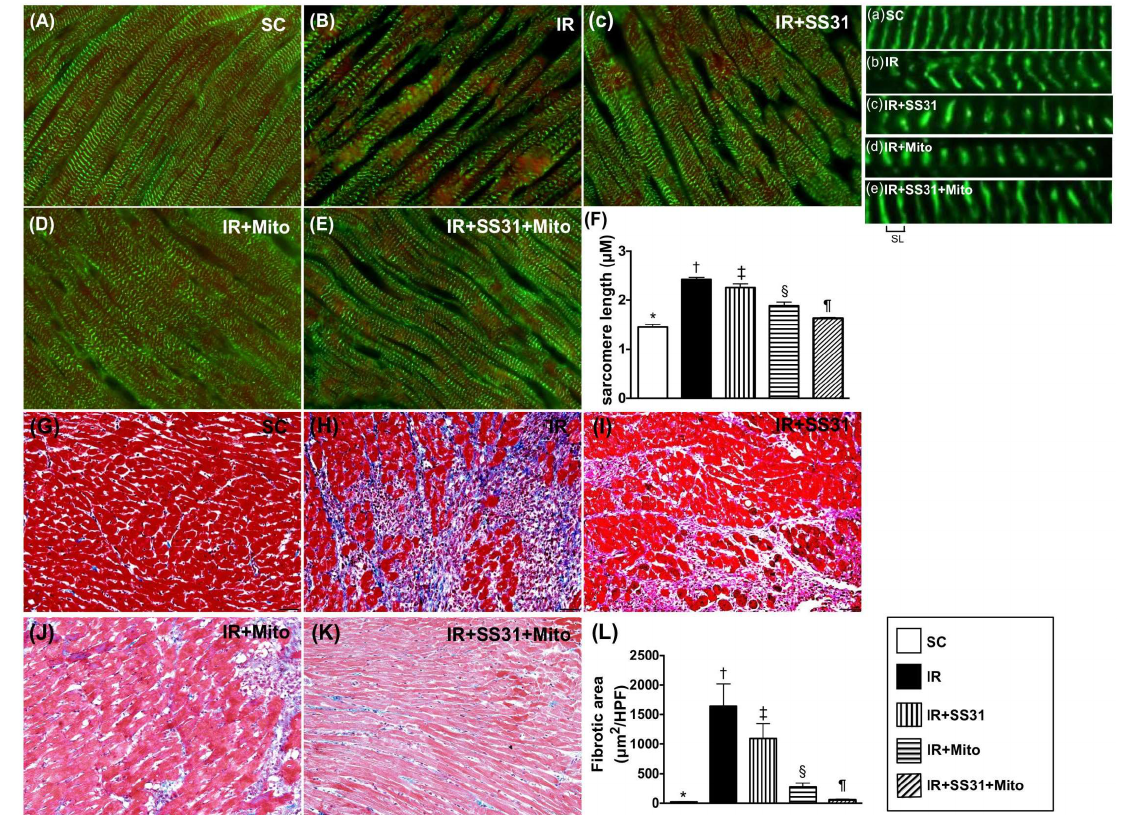
Figure 12. Actin-phalloidin staining ( A – E ) for measuring the sarcomere length of cardiomyocytes in LV myocardium after the IR procedure. ( A – E ) Immuno-fluorescent microscopic (1000 × ) finding for identifying the sarcomere length. ( a – e ) Illustrating the manifestations of distance of sarcomere length (SL) in five groups (i.e., ( A – E )). ( F ) Results of statistical analysis of the changes in length of sarcomere identified by troponin-I staining * vs. other groups with different symbols (†, ‡, §, ¶), p < 0.0001. The scale bars in the right lower corner represent 10 µ m. ( G – K ) Illustrating the Masson’s trichrome stain (200 × ) for identification of the fibrotic area (blue color). ( L ) Results of statistical analysis of the fibrotic area * vs. other groups with different symbols (†, ‡, §, ¶), p < 0.0001. All statistical analyses were performed by one-way ANOVA, which was followed by the Bonferroni multiple comparison post hoc test ( n = 8 for each group). Symbols (*, †, ‡, §, ¶) indicate significance at the 0.05 level. SC = sham control, IR = ischemia-reperfusion, and Mito = mitochondria.